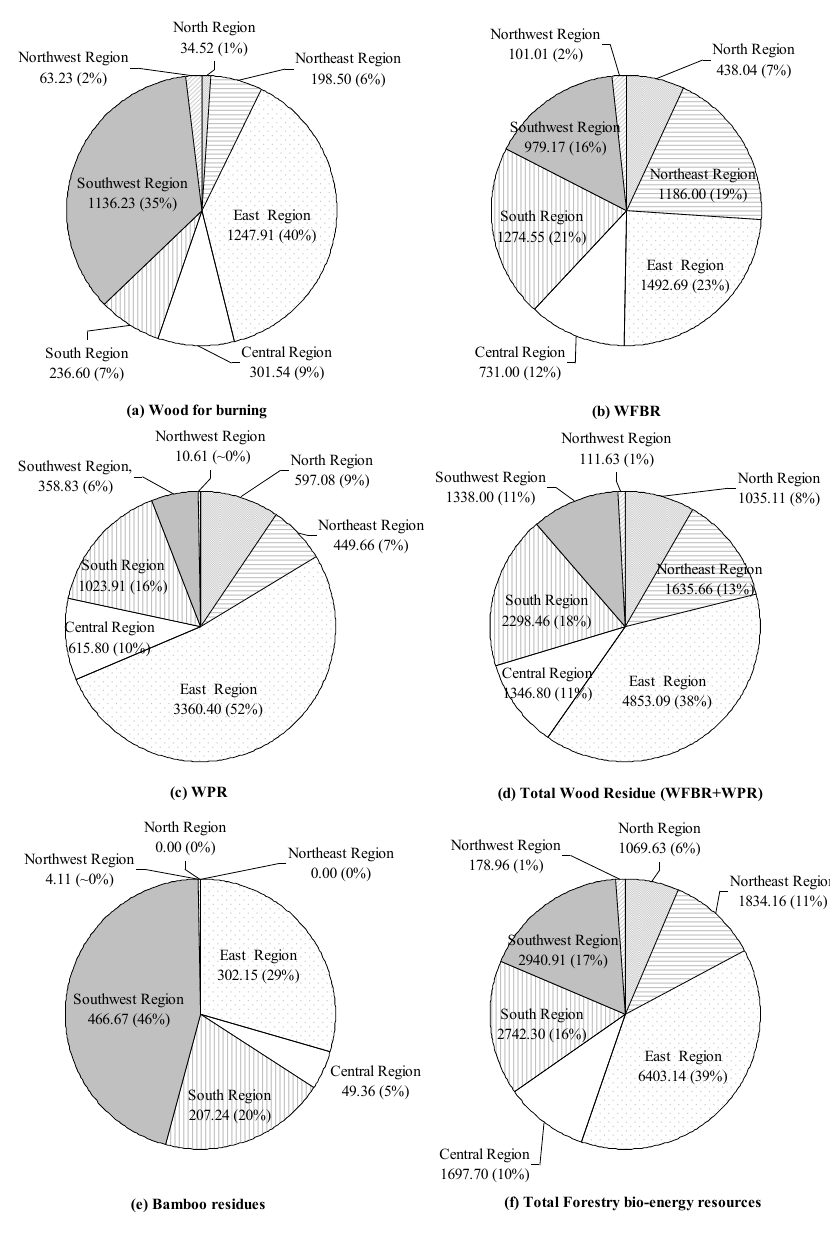
Figure 5. Contributions of forestry biomass energy resources from different regions of China in 2010. Wood for burning includes fuel wood and firewood; Total Wood Residues refer to the sum of wood felling and bucking residue (WFBR) and wood processing residue